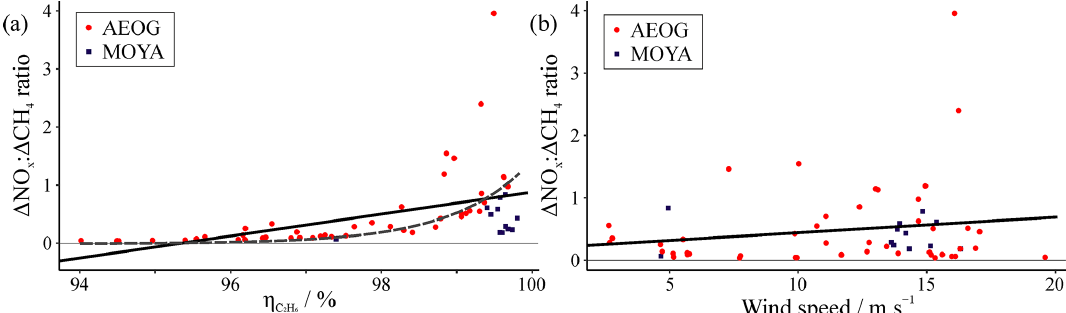
) and (b) wind 2 H 6